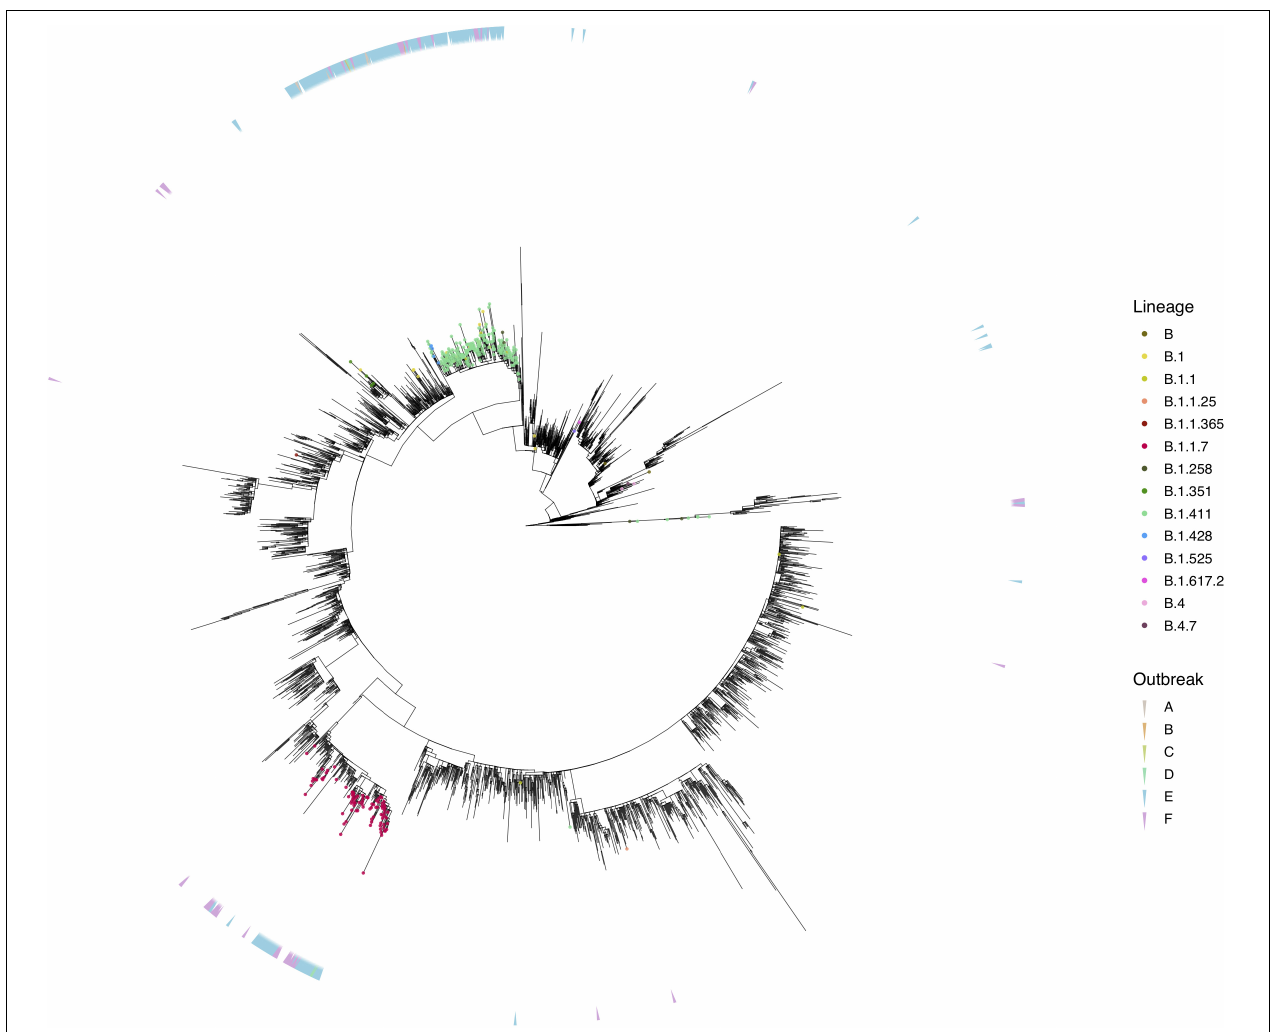
FIGURE 3 | Phylogenetic analysis of Sri Lankan sequences. Maximum likelihood tree of 373 Sri Lanka samples and 3,200 representative global sequences obtained from GISAID. Tips are coloured by Pango lineages, and the external layer on the right indicates the outbreak period associated with each Sri Lanka sample. The tree was estimated using IQTree2 (GTR maximum likelihood model and +G heterogeneity rate) and 1,000 replicates of ultrafast bootstrapping ( − B 1000) and SH-aLRT branch test ( − alrt 1000).